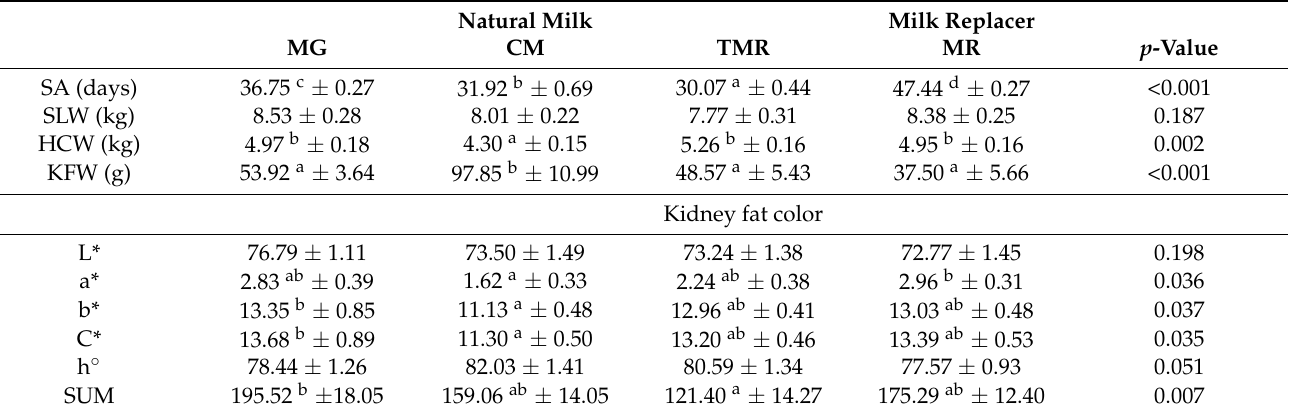
Table 2. The mean, standard error, and p -value (ANOVA) of the effect of the feeding system on the carcass traits and kid net fat color variables. Natural Milk Milk Replacer MG CM TMR MR p